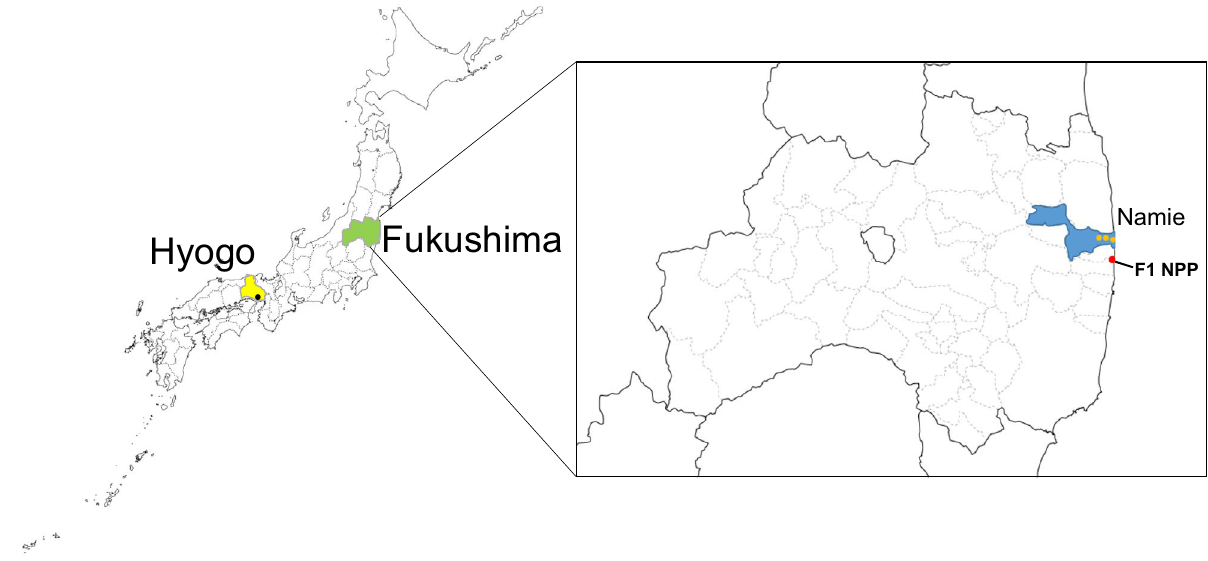
Figure 1. Map of Japan showing the location of Hyogo (yellow) and Fukushima (green) Prefectures where the samples were collected. Orange circles show the sampling site in Fukushima. The black circle indicates the sampling site in Hyogo. The red circle indicates the place of the Fukushima Daiichi Nuclear Power